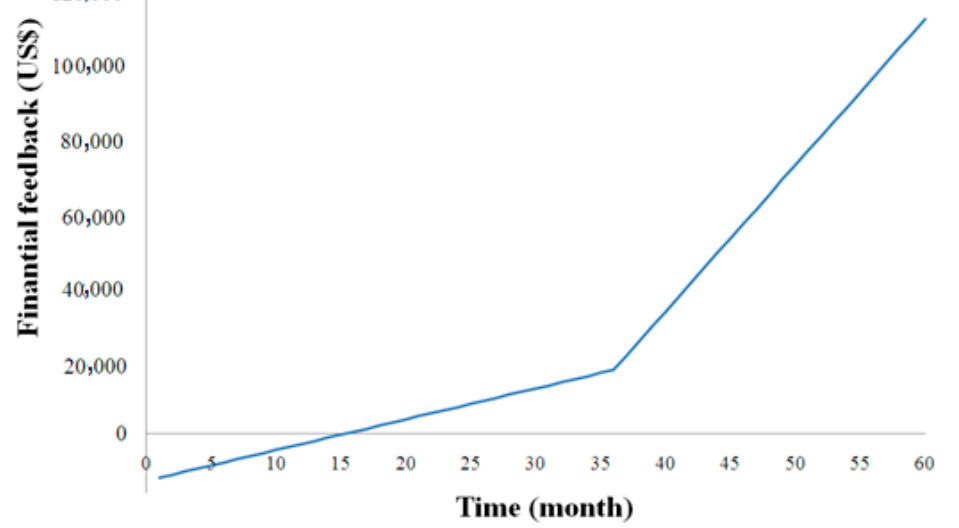
Figure 6. Financial feedback curve of the smart grid project.